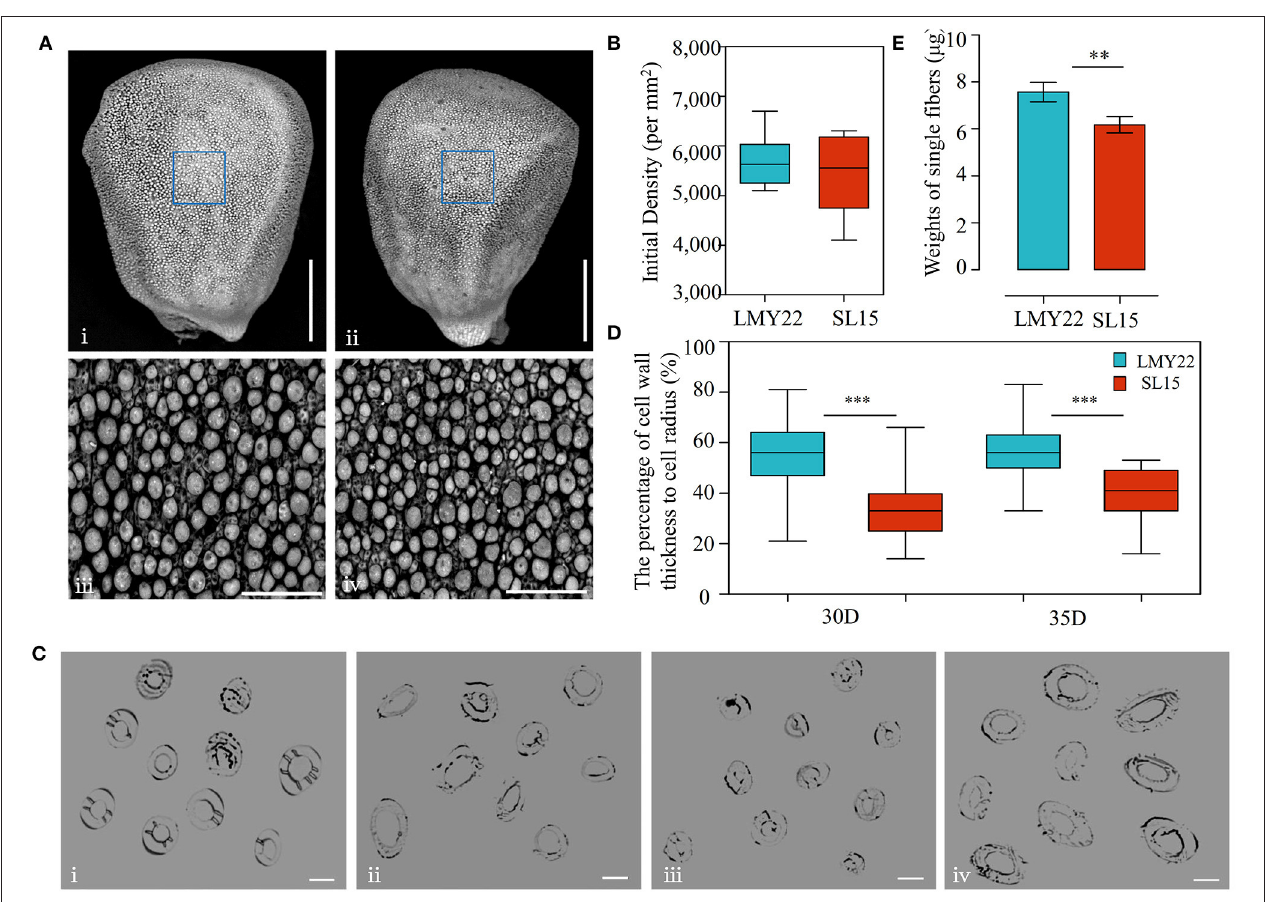
FIGURE 2 | Detection of fiber initiation and cell wall thickness. (A) TEM view of fiber initiation at 0 DPA; (i) and (ii) present the whole ovule of LMY22 and SL15, respectively, scale bar, 500 µ m; (iii) and (iv) present close-up views of LMY22 and SL15, respectively, scale bar, 50 µ m. (B) Counts of fiber initiations, mean ± s.d., n = 20. (C) Cross-sections of cotton fiber cells; (i) and (ii) present LMY22 and SL15 at 30 DPA, respectively; (iii) and (iv) present LMY22 and SL15 at 35 DPA, respectively; scale bar, 20 µ m. (D) Ratio of cell wall thickness to cell radius (as percentage), mean ± s.d., n = 100, *** P < 0.001. (E) Weights of single fibers, mean ± s.d., n = 50, ** P < 0.01 and *** P <